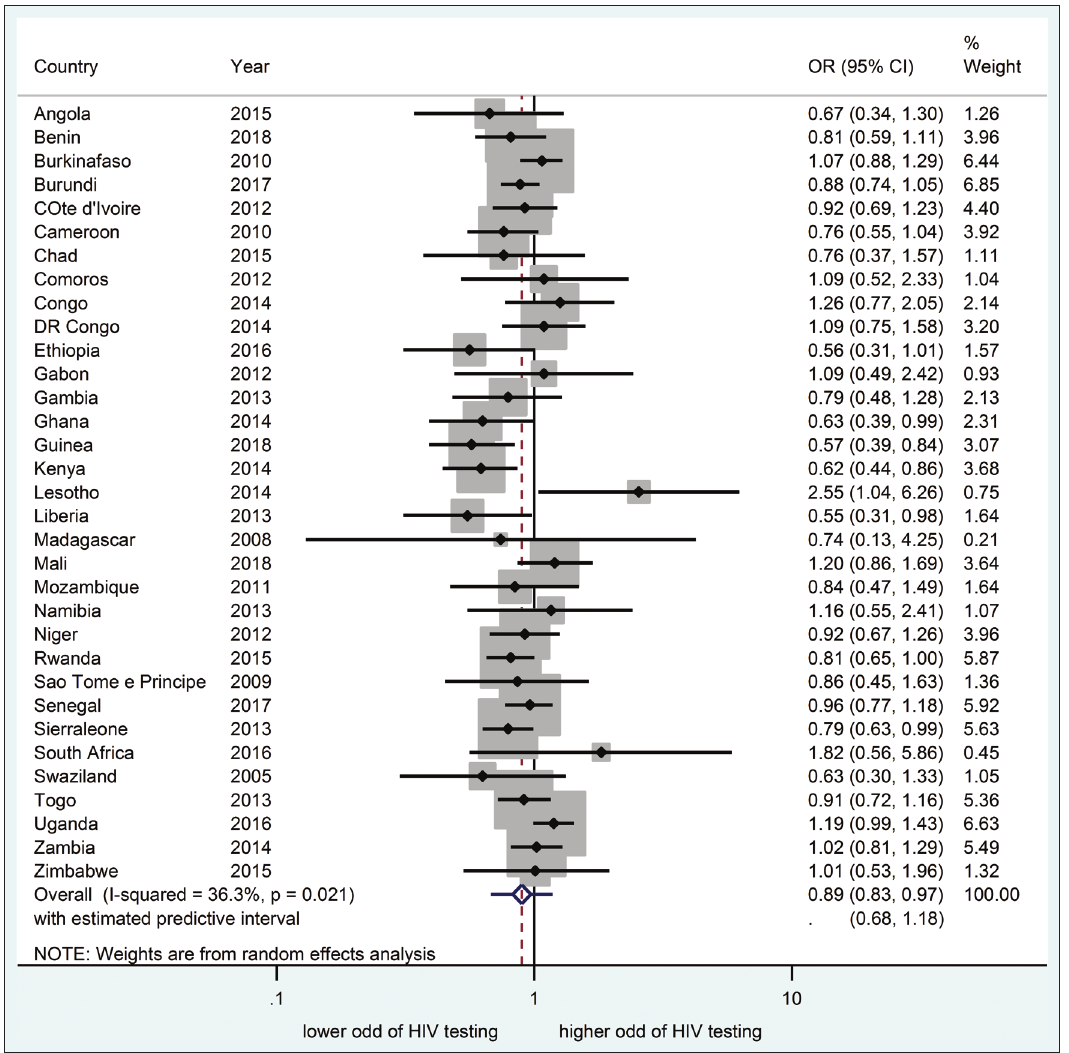
Figure 1: Forest plot showing the effect of having participated in one or two decisions related to women’s own health, visiting family or relatives and large household purchases on HIV